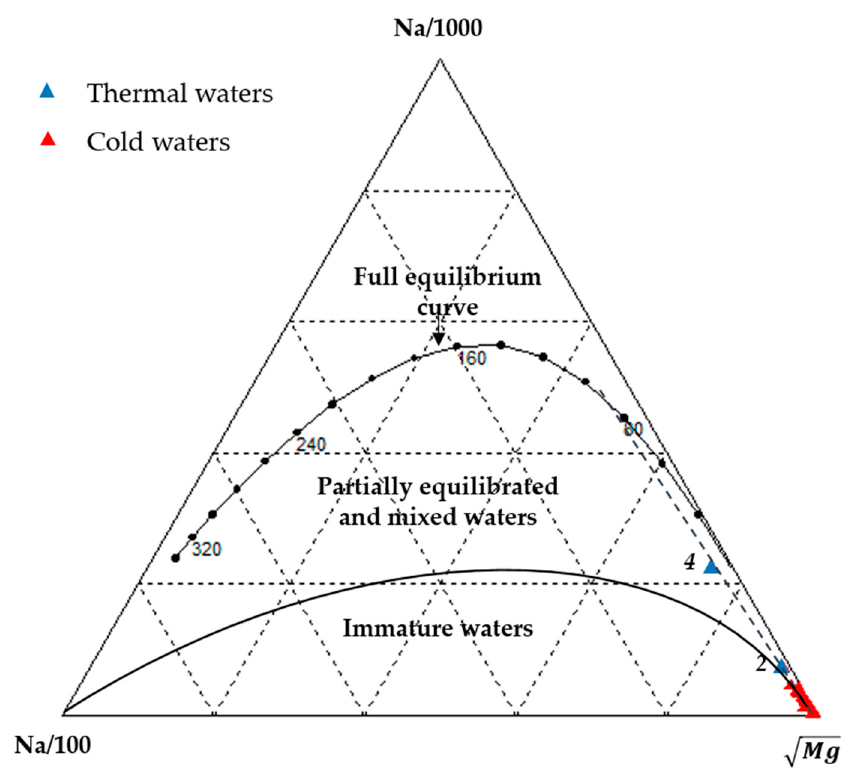
Figure 4. Giggenbach triangular diagram (Na-K-Mg).